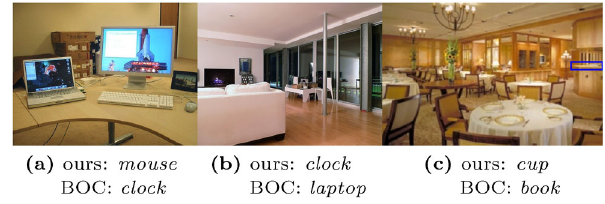
Fig. 4 Qualitative comparison of most highly recommended